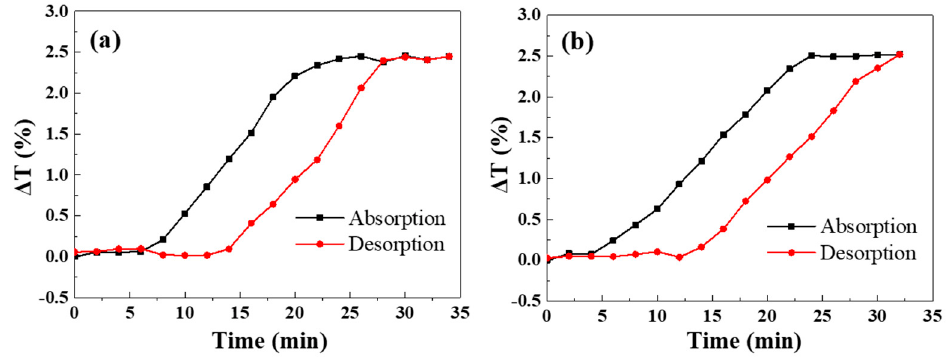
Figure 5. Transmittance change curve of Pd NTA samples upon hydrogen absorption and desorption processes (( a ) P500; ( b ) P300).